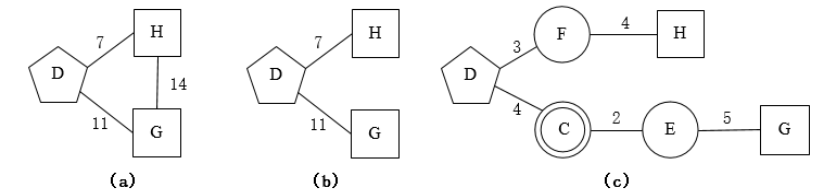
Figure 7. An example of Steiner tree. ( a ) the complete graph; ( b ) the minimal spanning tree (MST) of ( a ); and ( c ) a Steiner tree by replacing the link with the shortest path in G